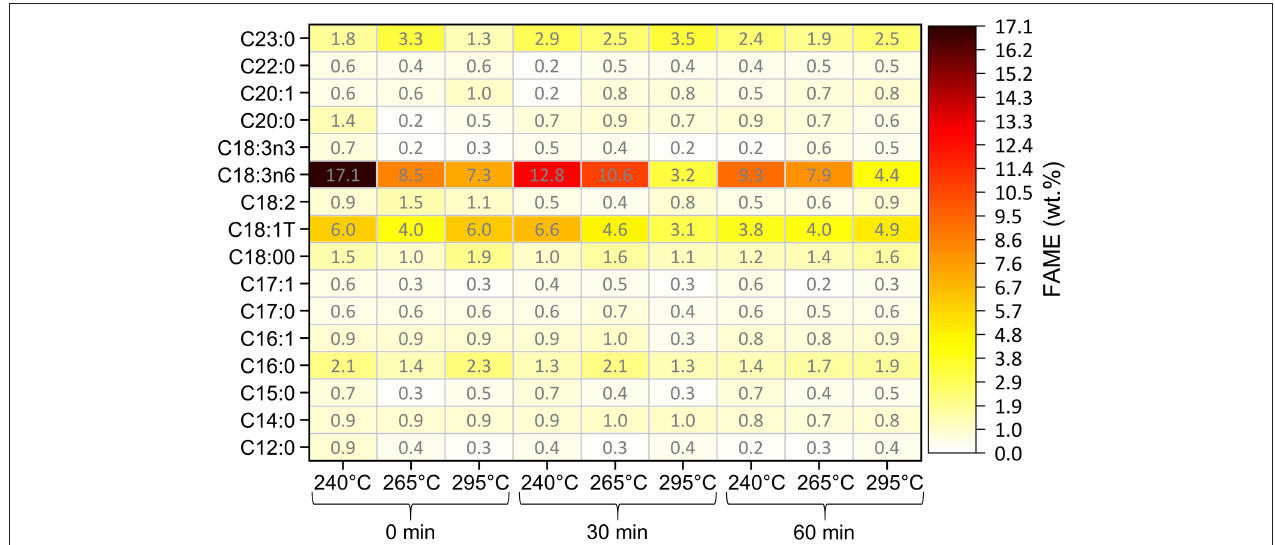
FIGURE 3 | Heat map quantifying fatty acid methyl ester (FAME) distribution in bio-crude oil under different HTL temperature and reaction time conditions. Numbers in heat map represent FAME wt.% on a dry feed basis.